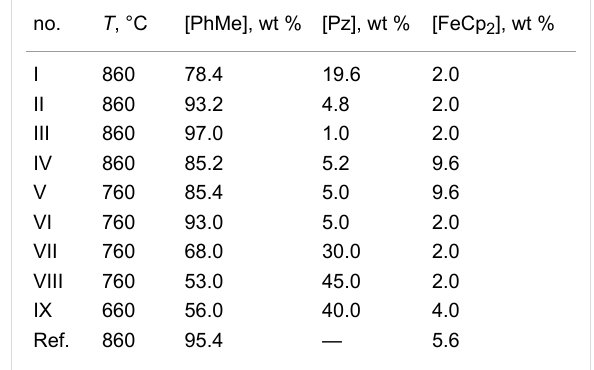
Table 2: Composition of the feedstock and growth temperatures in the syntheses of N-CNTs. The growth time was equally 4 h in all of the